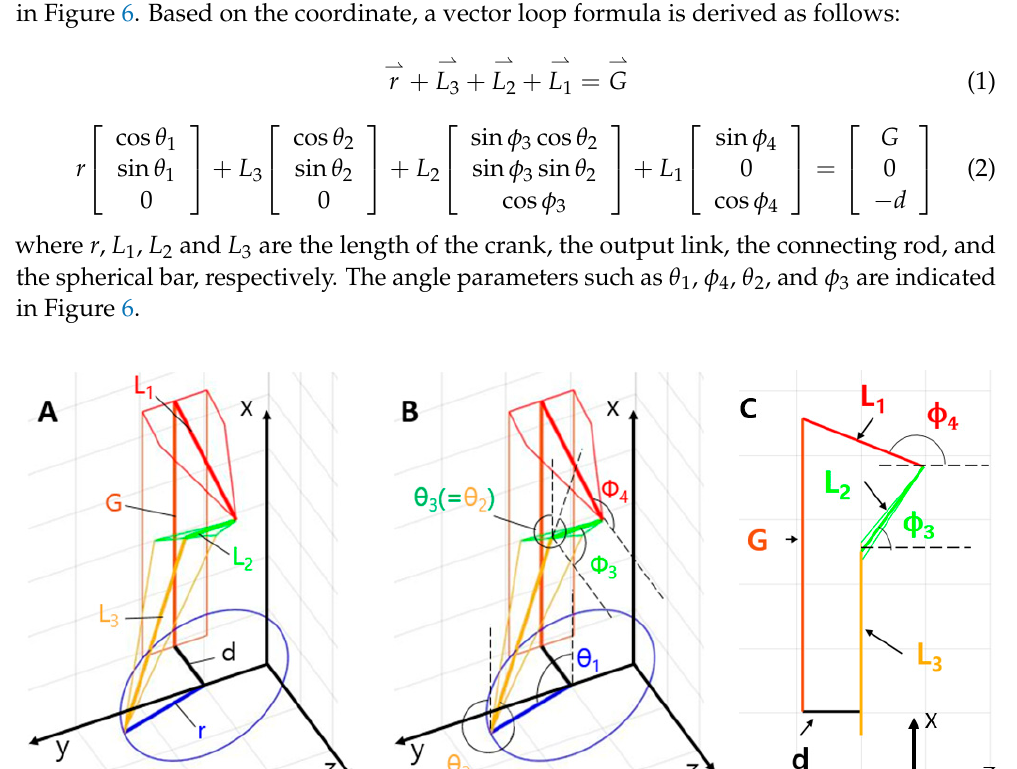
Figure 5. The secondary condition. A non ‐ optimized case and an ideal case are simultaneously shown to compare the difference.